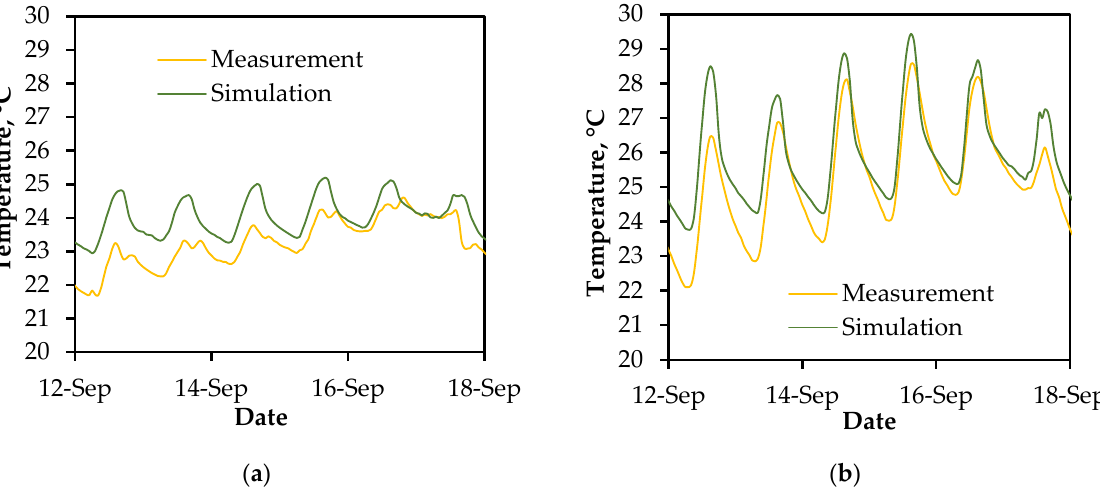
Figure 7. Variation in the hourly average measured and calculated indoor temperature for period of 18–25 June 2020 in: ( a ) living room; ( b ) room 1.